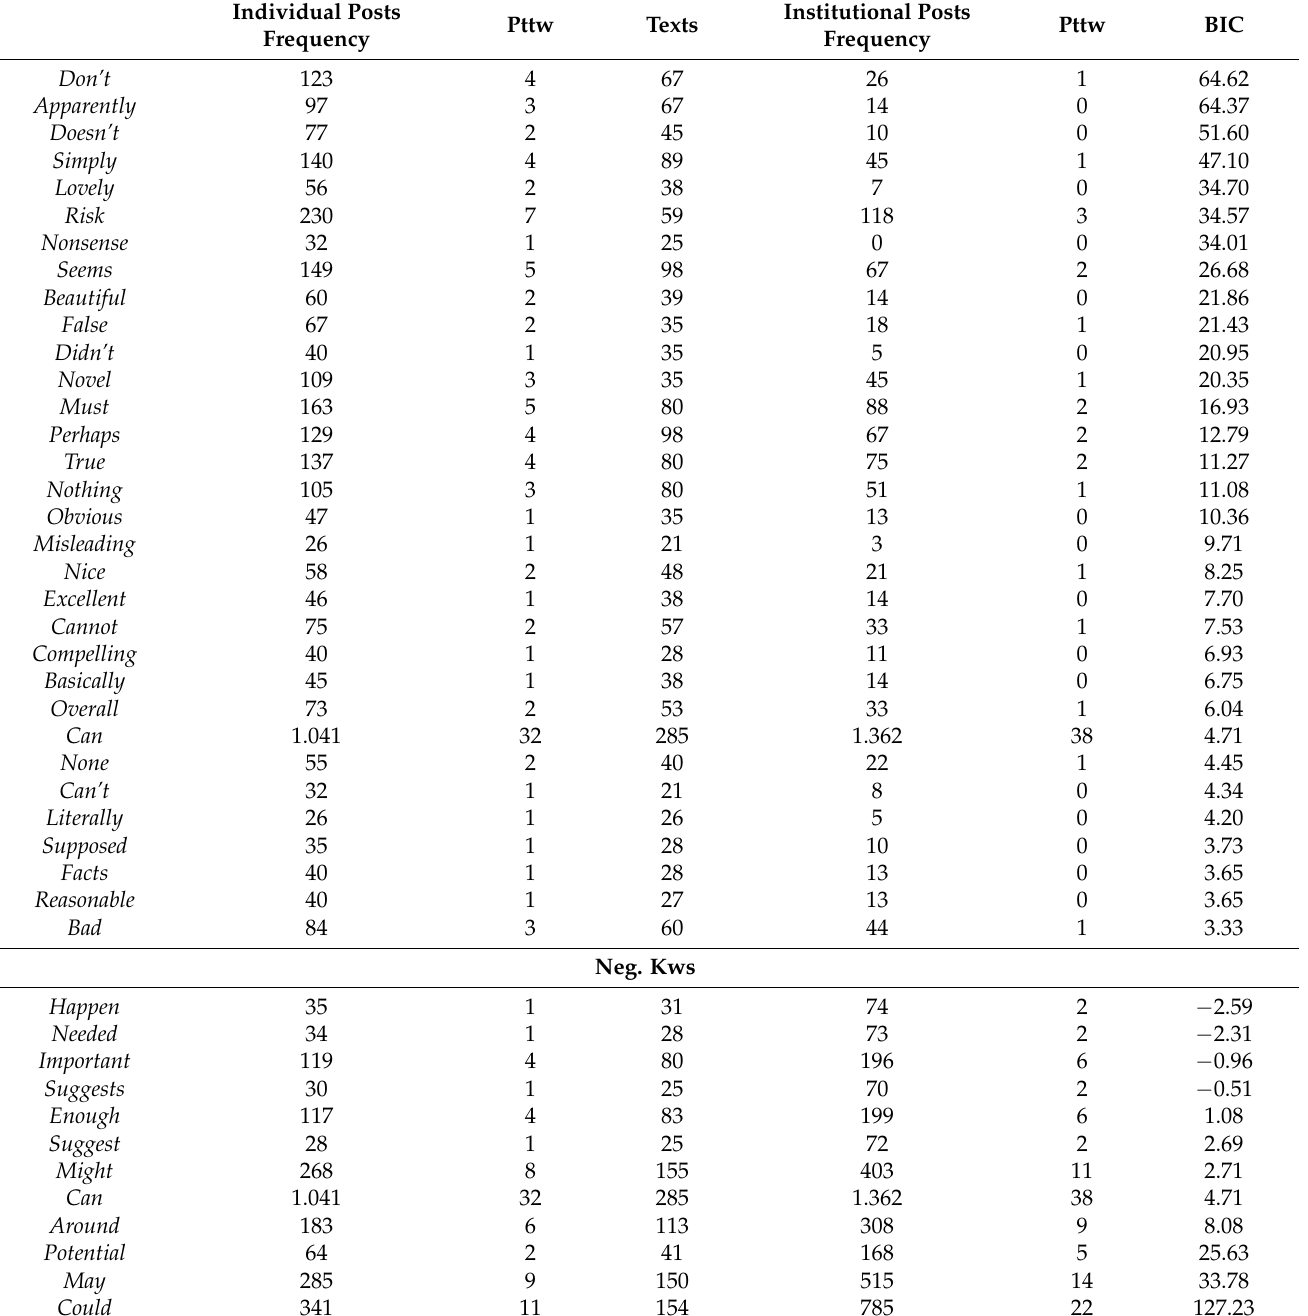
Table 7. Elements of evaluative dialogue: individual vs. institutional blog